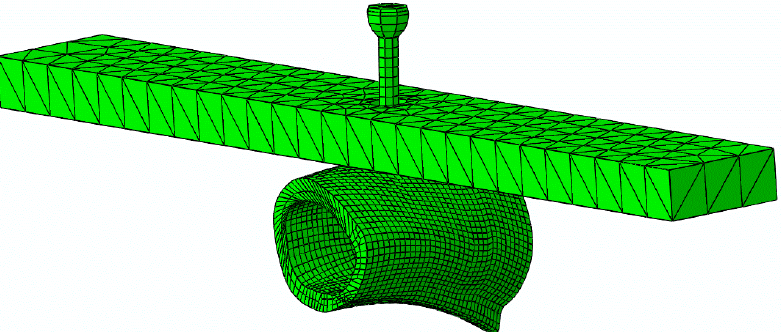
Figure 7. Finite element mesh of the pull ‐ out screw (POS) test.